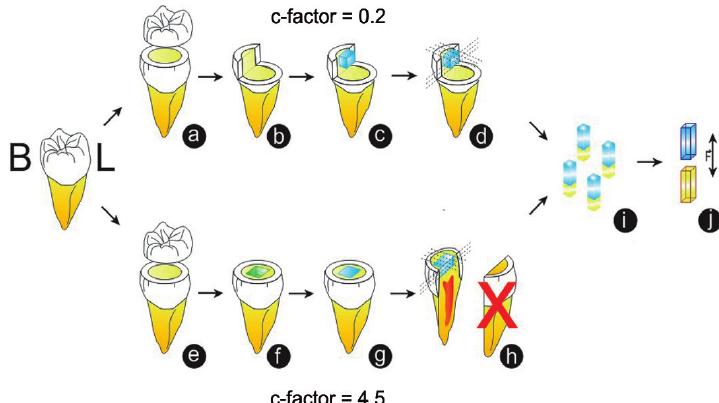
Figure 2- a- Flat Surface cavity model – removal of occlusal enamel; b- Cavity preparation and removal of all the walls, except the vestibular wall (control); c- Resin block fabrication; d- Cuts to obtain specimens for microtensile test; e- Class I cavity model – removal of occlusal enamel; f- Preparation of occlusal cavities; g- Restoration of cavities in a single increment; h- Cuts to obtain specimens for microtensile test; i- Specimens for microtensile test; j - Microtensile